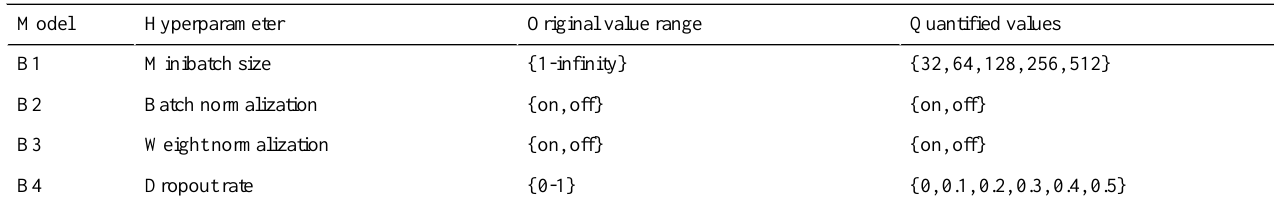
Table 1. Specification of the hyperparameter space for the model B family. Minibatch size and dropout rate are quantified to avoid an exhaustive search.